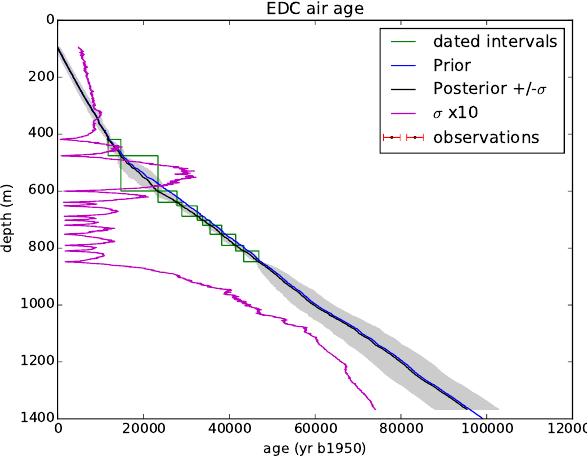
Figure 8. Experiment test-air-intervals-with-known-durations. EDC prior (blue) and posterior (black) chronologies and the pos- terior confidence interval (grey area) when using independent CH4 intervals with known durations from the GICC05 layer-counted timescale (green rectangles; Svensson et al., 2008). The 1 σ uncer- tainty of the posterior timescale is also shown on the left (pink). This figure is automatically produced by IceChrono1.